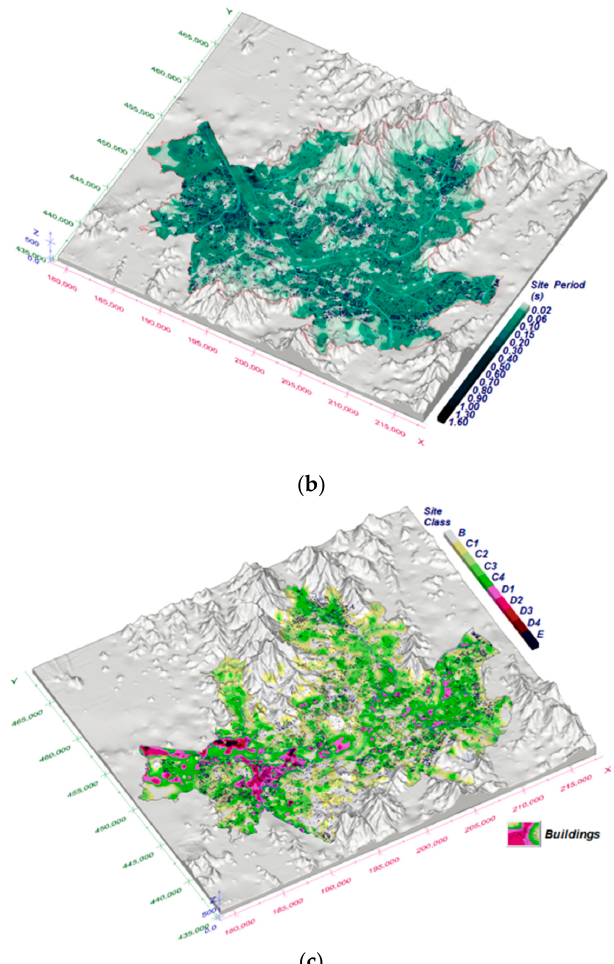
Figure 3. Site response spatial information for Seoul: ( a ) bedrock depth, ( b ) site period, ( c ) site classification (modified after Sun et al. [26]).